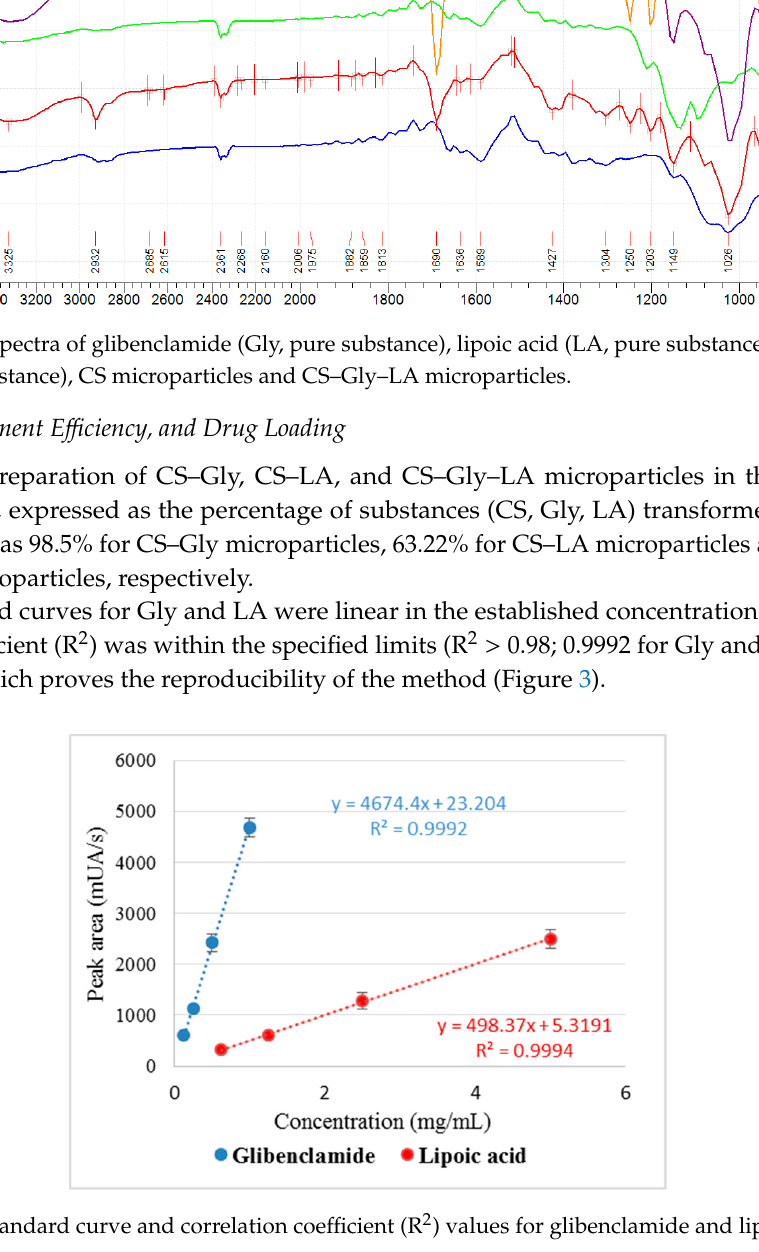
Figure 2. IR spectra of glibenclamide (Gly, pure substance), lipoic acid (LA, pure substance), chitosan